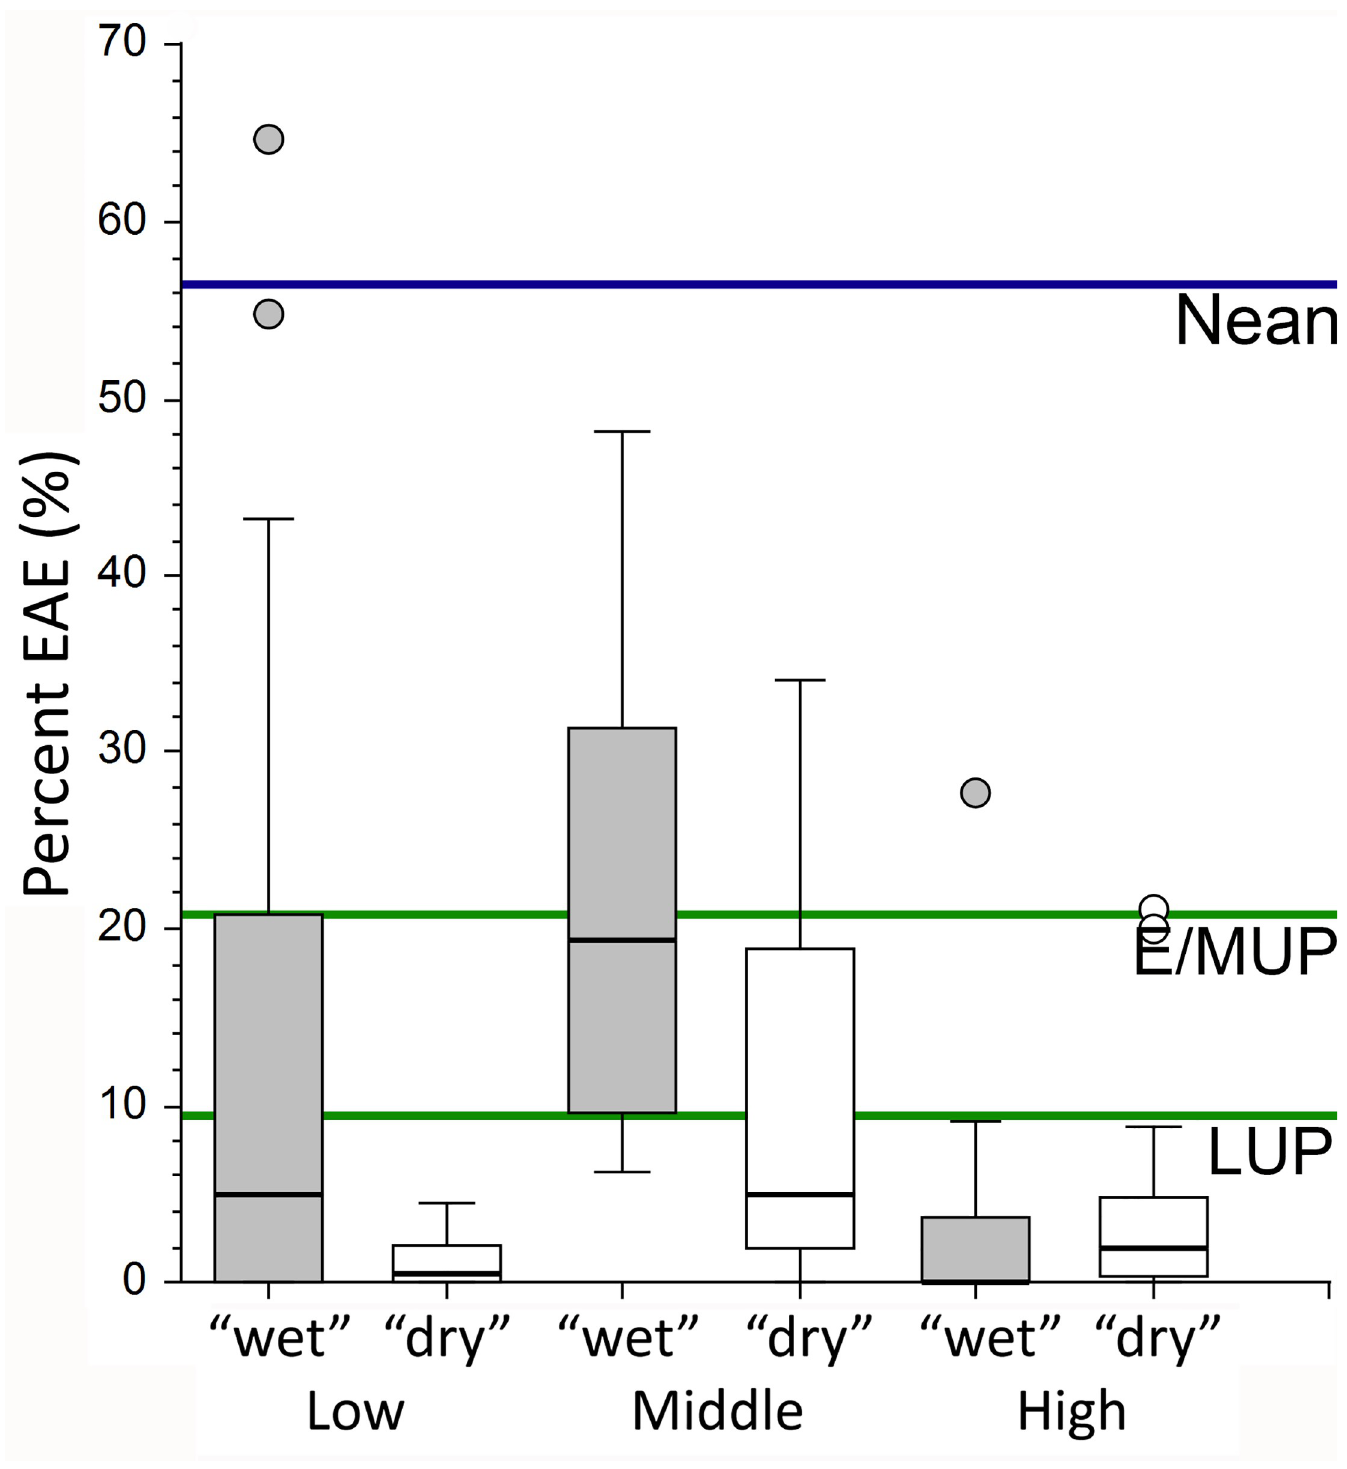
Fig 1. Percent presence of external auditory exostoses (EAE) in samples of Neandertals, Early/Mid Upper Paleolithic modern humans (E/MUP), Late Upper Paleolithic modern humans (LUP), and latitudinal samples of recent humans. The recent humans are divided into low ( < 30˚), middle (35˚– 40˚) and high ( > 40˚) latitude samples, and each one is then separated into coastal/riverine/lacustrine (“wet”) and inland (“dry”) samples; see S2 Table for justification and individual sample percentages. The 95% CIs for are 34.5%– 76.8% for the Neandertals, 4.8%– 48.5% for the E/MUP sample, and 1.2%– 30.4% for the LUP sample.